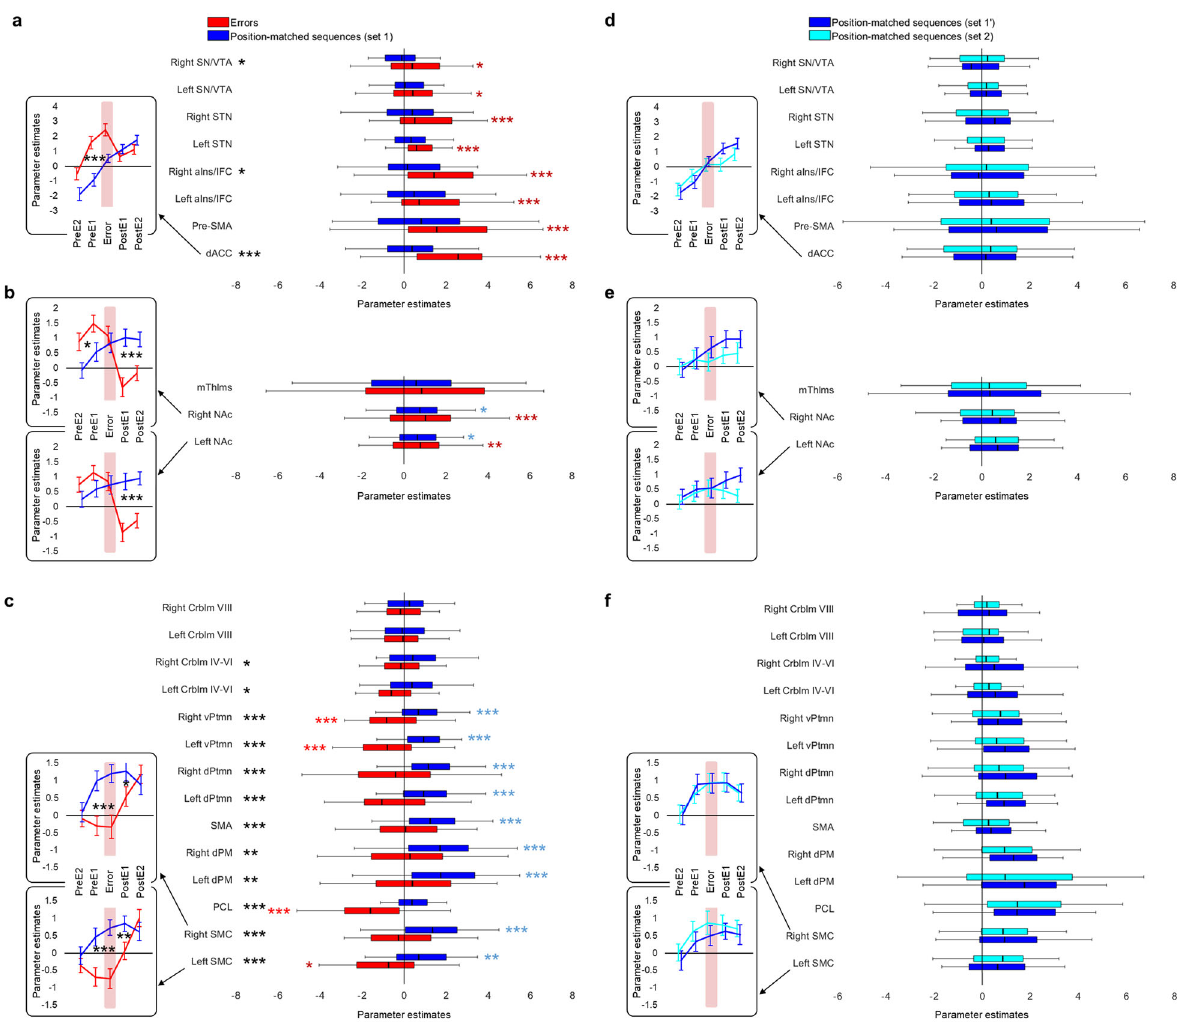
Fig. 6 Activity levels during errors and their position-matched sequences versus rest. Parameter estimates at the onset of the errors (red) and position- matched sequences (blue), versus rest (zero values along the x -axis), extracted for regions of interest (ROIs; Table 3) with a , d error-speci fi c activity increases, b , e post-error activity decreases, and c , f error-speci fi c activity suppression. Black asterisks indicate signi fi cant differences between errors and position-matched sequences; red and blue asterisks indicate signi fi cant activity increases/decreases during errors and position-matched sequences, versus rest, respectively. *, ** and *** - signi fi cant results at 0.05, 0.01 and 0.001 level respectively; in the later case, the results are signi fi cant after Bonferroni correction for 25 ROIs included in the analysis ( p < 0.002). The abbreviations for brain regions are the same as in Fig. 5. PreE2 and PreE1 — two consecutive sequences before the error, PostE1 and PostE2 — two consecutive sequences after the error. Error bars represent standard error of the mean